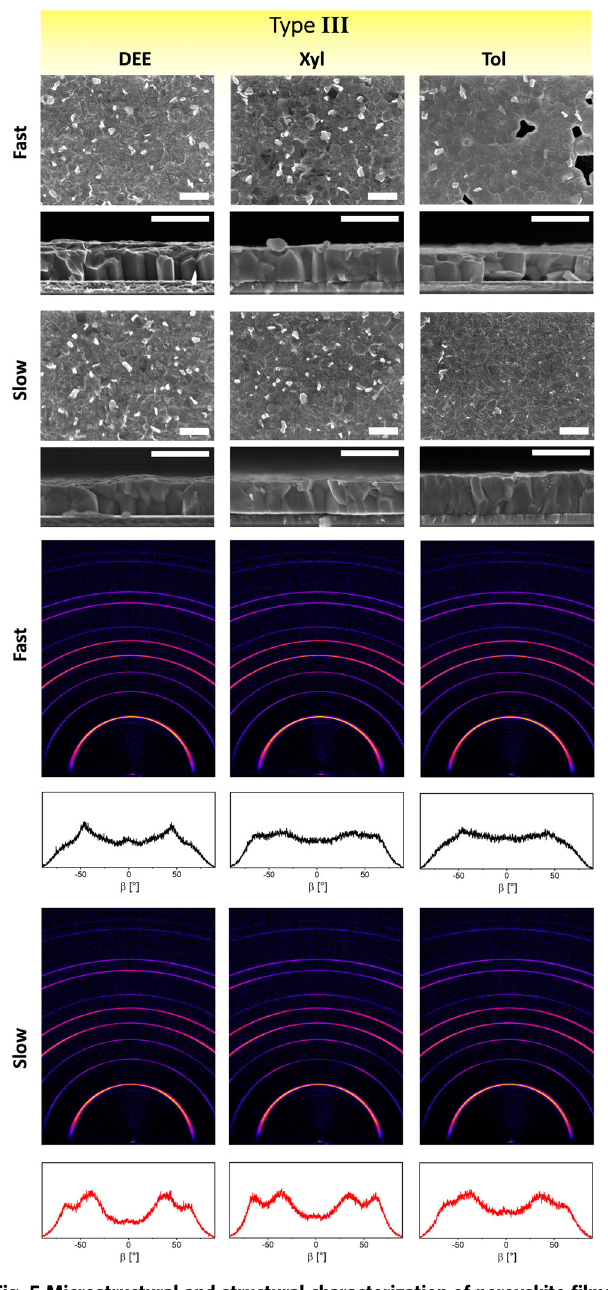
Fig. 5 Microstructural and structural characterization of perovskite fi lms deposited by type III antisolvents. Top: surface and cross-sectional scanning electron microscopy images of perovskite fi lms formed from selected type III antisolvents (DEE, Xyl, and Tol). Scale bar is 1 μ m. Bottom: 2D XRD maps and corresponding ß integration of the (100) re fl ection to visualize changes in grain